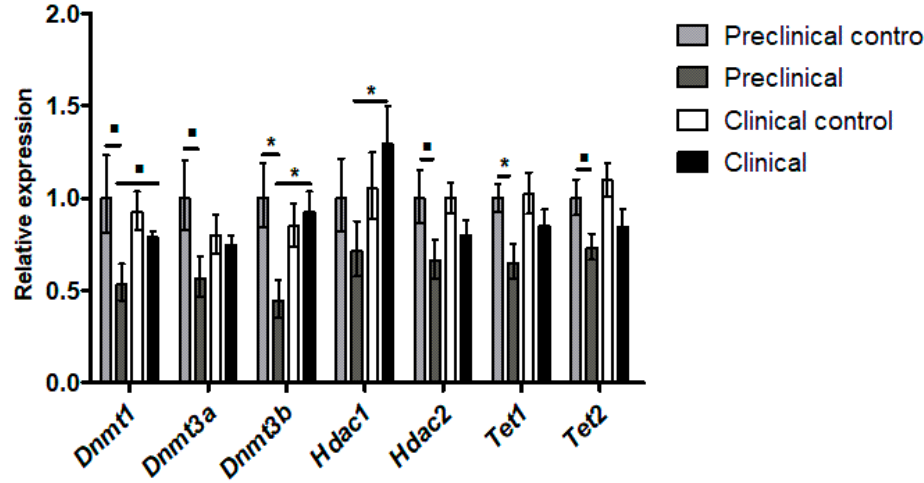
Figure 2. Relative expression levels in terms of 2 − ∆∆ Ct of epigenetic regulatory genes in the thalamus of Tg338 mice. ▪ p = 0.1; * p < 0.05.